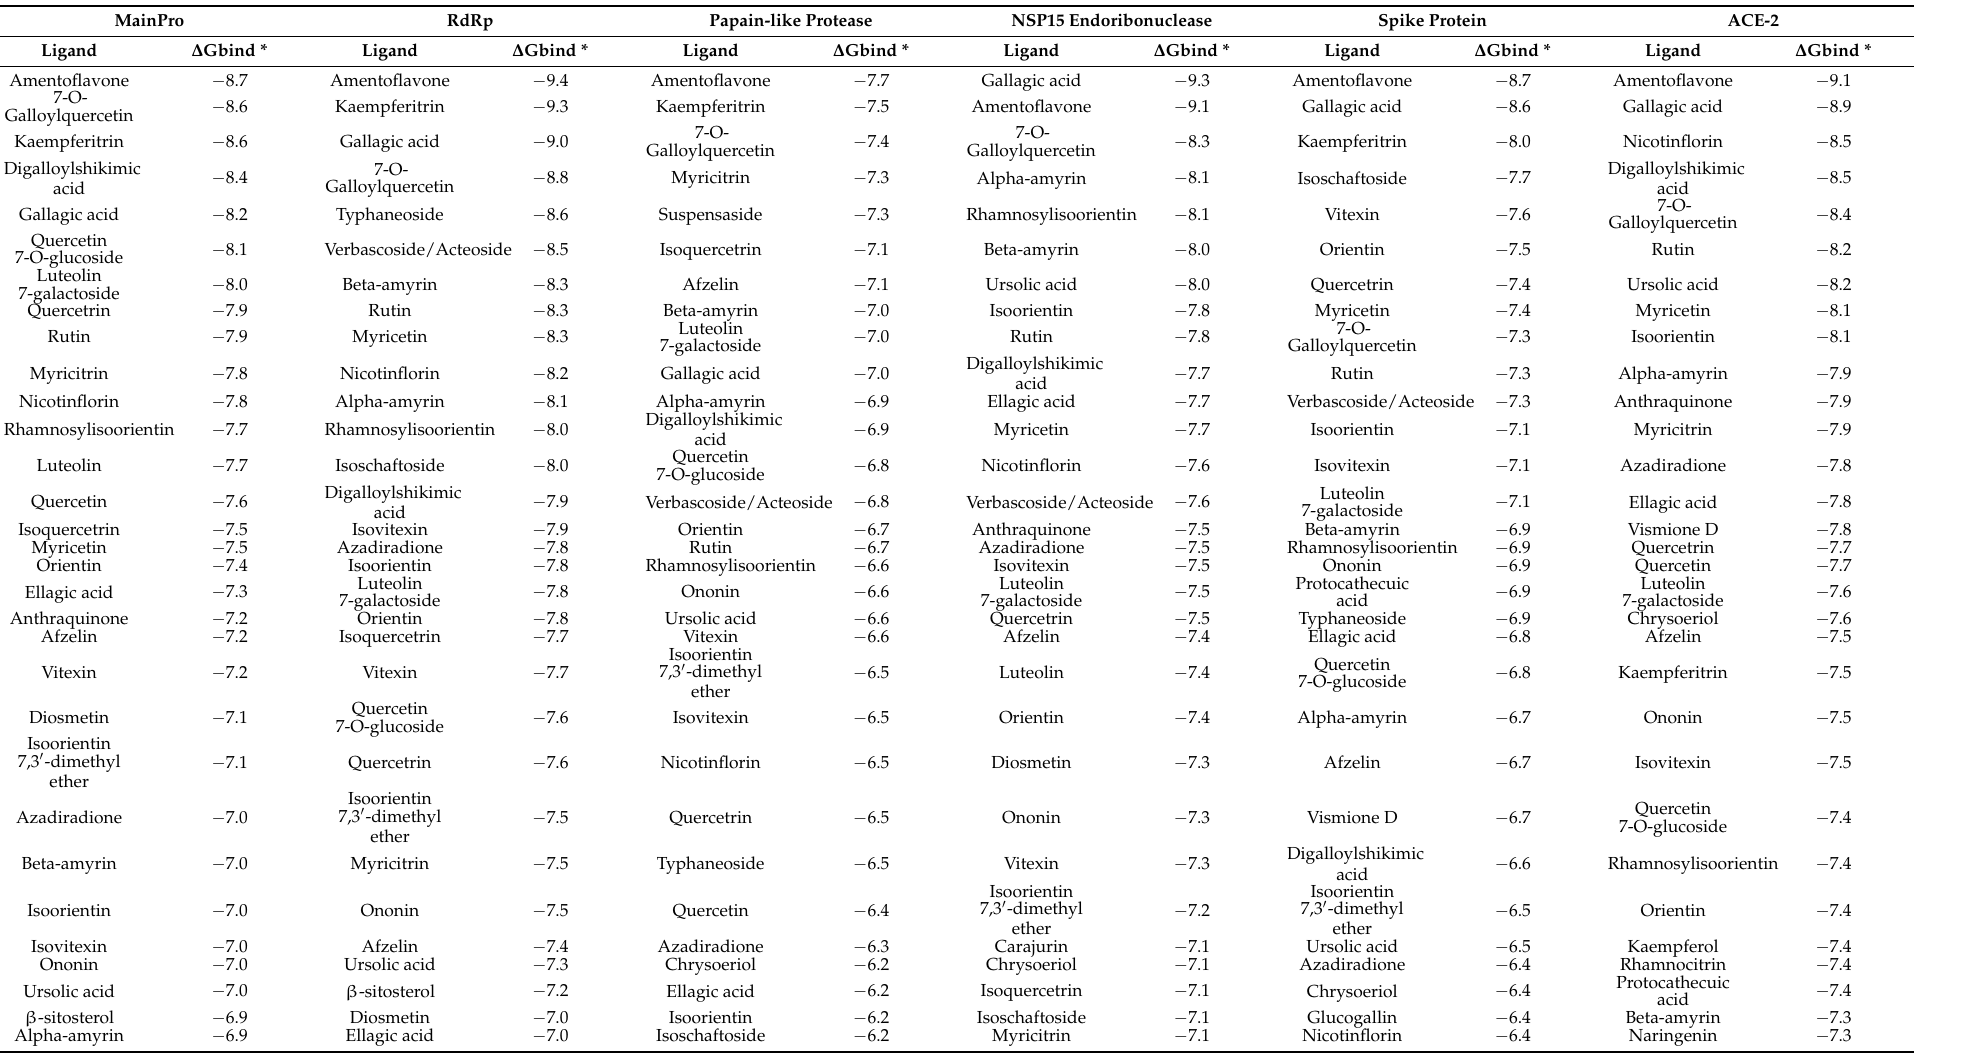
Table 1. Free binding energies values obtained by molecular docking of the 55 plant metabolites against SARS-CoV-2 main drug